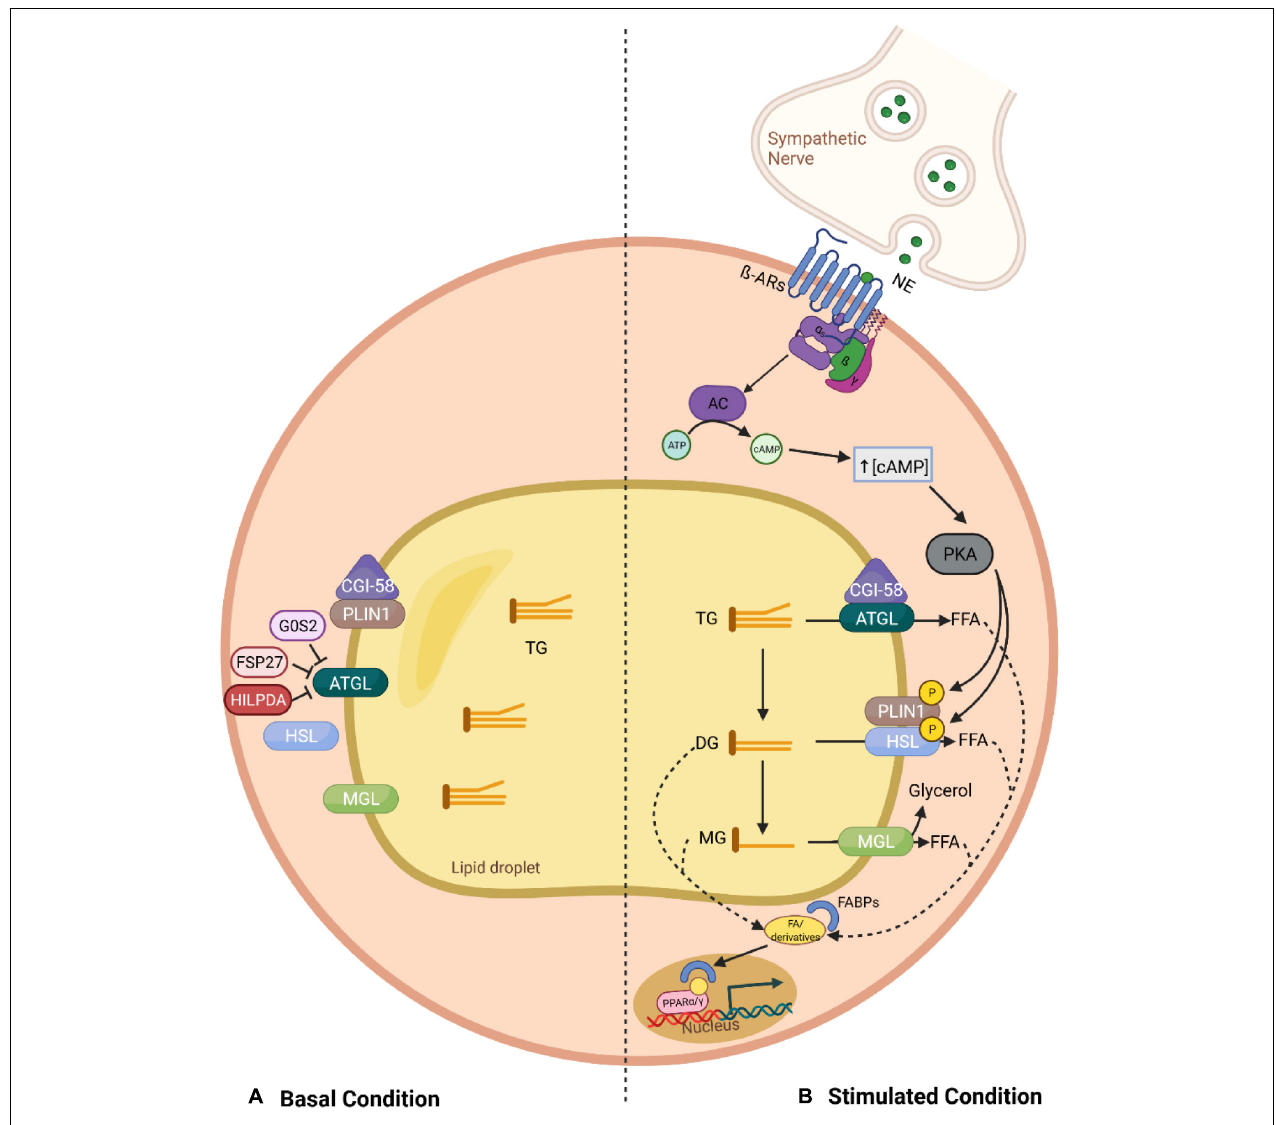
FIGURE 1 | Overview of the canonical lipolysis pathway in adipocytes. (A) In the basal status, PLIN1 sequesters CGI-58, the co-activator of ATGL, limiting its function. This, together with the fact that ATGL can be further inhibited through direct interaction with G0S2 and FSP27, leads to a low TG hydrolysis rate. (B) In stimulated lipolysis, norepinephrine, secreted by sympathetic nerves innervating the adipose tissue, binds to β adrenergic receptors and activates AC. Consequently, there is an increase in the cytosolic levels of cAMP, which stimulates PKA, a kinase that phosphorylates PLIN1 and HSL. The phosphorylation of PLIN1 results in the release of CGI-58, which can then bind to ATGL, promoting the hydrolysis of TGs into DGs. In addition, upon phosphorylation of HSL, this lipase relocates to the lipid droplet surface where it can interact with PLIN1 and degrades DGs into MGs, which are further processed by MGL. Finally, the fatty acids generated in each lipolytic step, and their derivatives, can act as signaling ligands or as precursors for ligands of PPAR α / γ and stimulate the expression of genes involved in energy homeostasis. AC, adenylyl cyclase; AR, adrenergic receptor; ATGL, adipose triglyceride lipase; ATP, adenosine triphosphate; cAMP, cyclic adenosine monophosphate; CGI-58, comparative gene identification 58; DG, diglyceride; FFA, free fatty acid; FABP, fatty acid-binding protein; FSP27, fat specific protein 27; G0S2, G0/S2 switch protein 2; HILPDA, hypoxia-induced lipid droplet-associated protein; HSL, hormone-sensitive lipase; MG, monoglyceride; MGL, monoglyceride lipase; NE, norepinephrine; PKA, protein kinase A; PLIN1, perilipin 1; PPAR, peroxisome proliferator-activated receptor; TG,